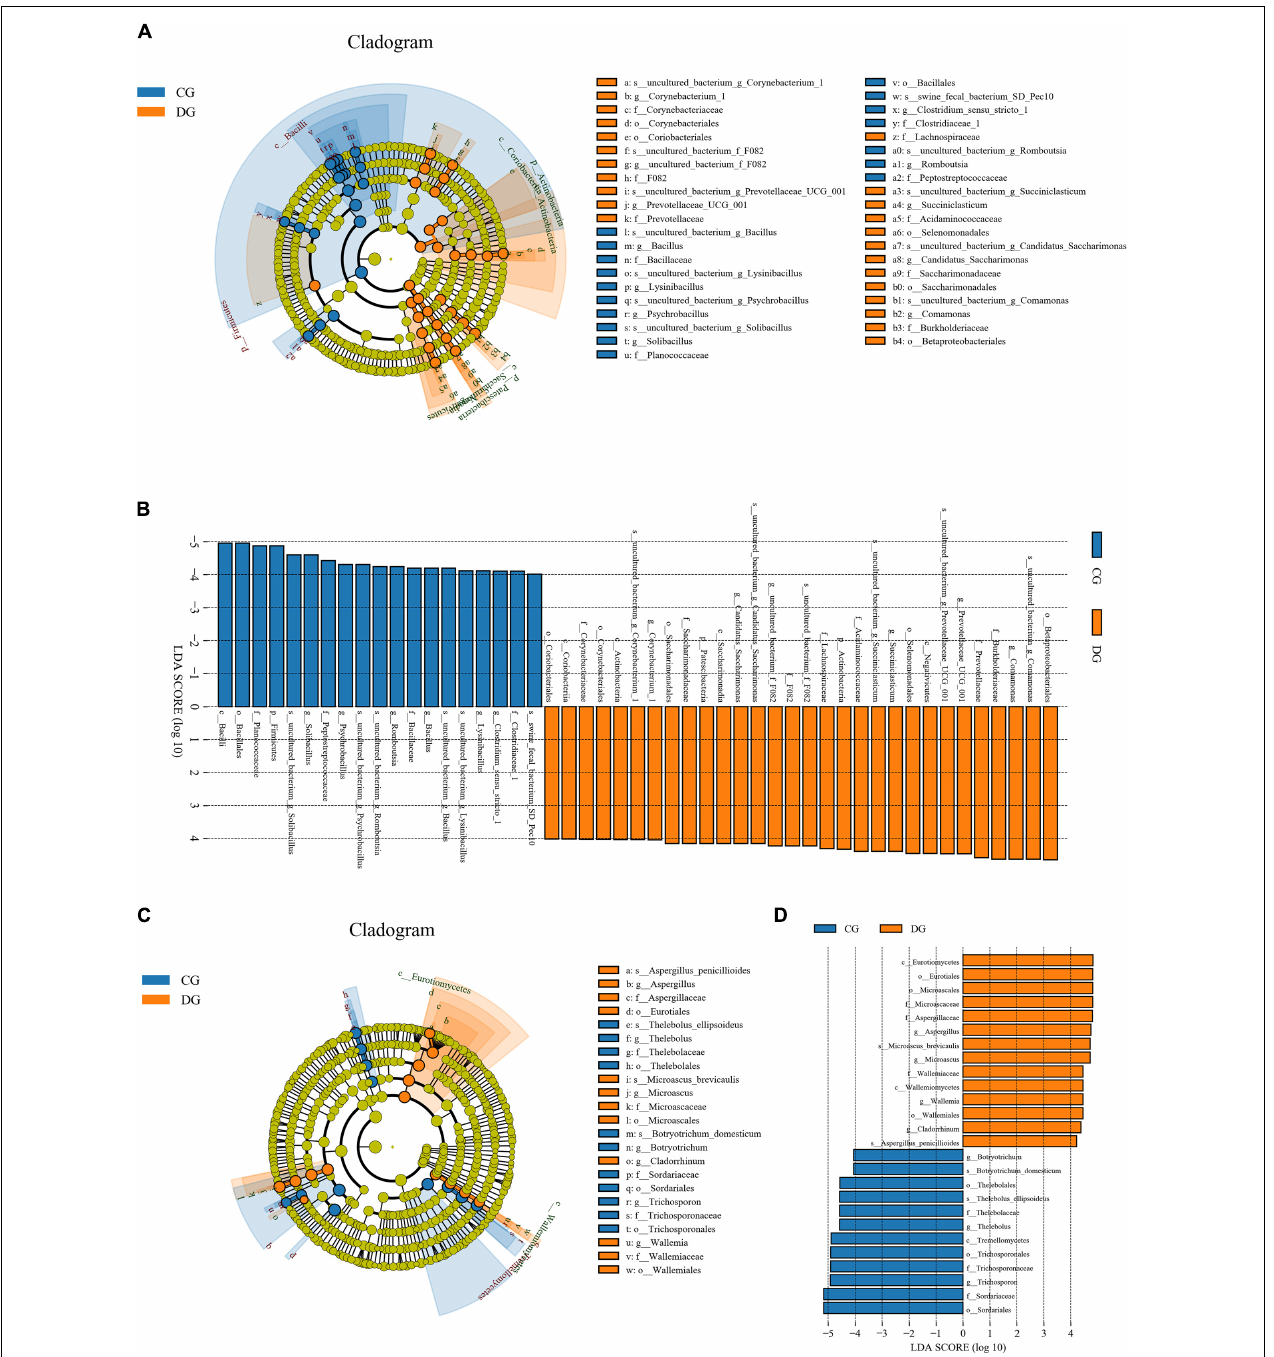
FIGURE 5 | LEfSe analysis integrated with LDA scores revealed differential biomarkers associated with diarrhea in giraffes. (A,C) Cladogram revealing the phylogenetic distribution of intestinal bacteria and fungus correlated with the control or diarrheic groups. (B,D) The differences in the relative abundance of bacteria and fungi between the control and the diarrheic groups. LDA scores > 4 was considered statistically